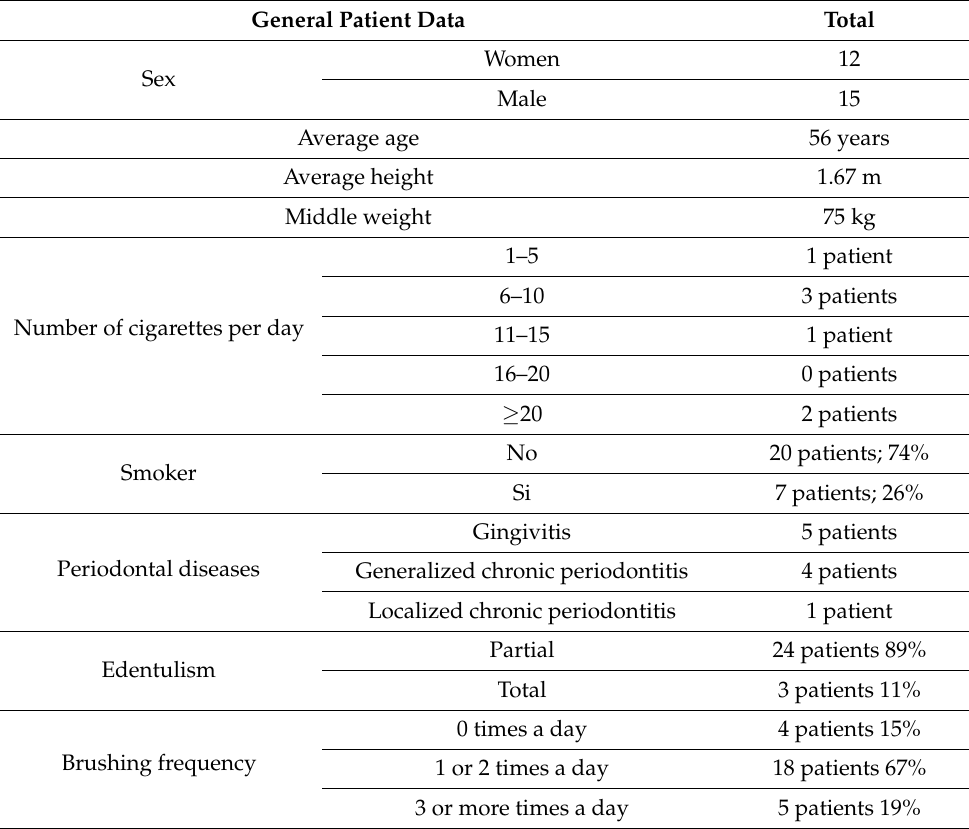
Table 1. General patient data.